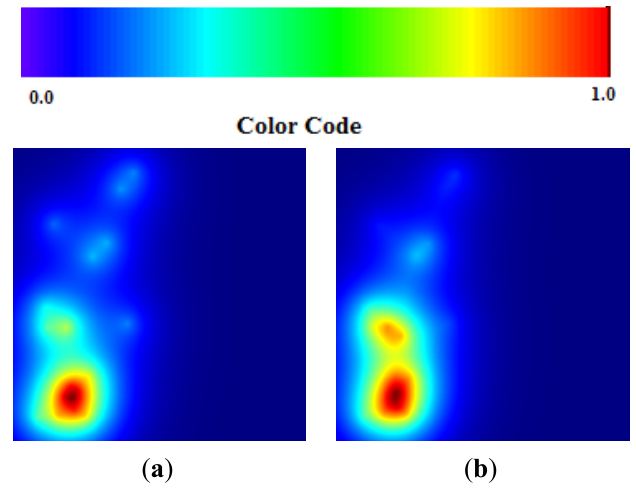
Figure 6. ( a ) Chikungunya TWC ( β ); ( b) Chikungunya TWC ( γ